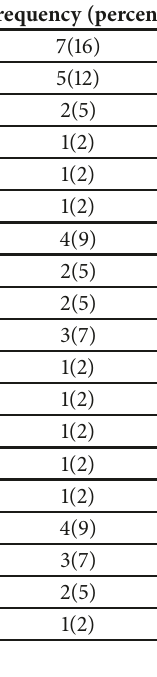
Table 2: Frequency of mutations in Familial Mediterranean Fever patients and